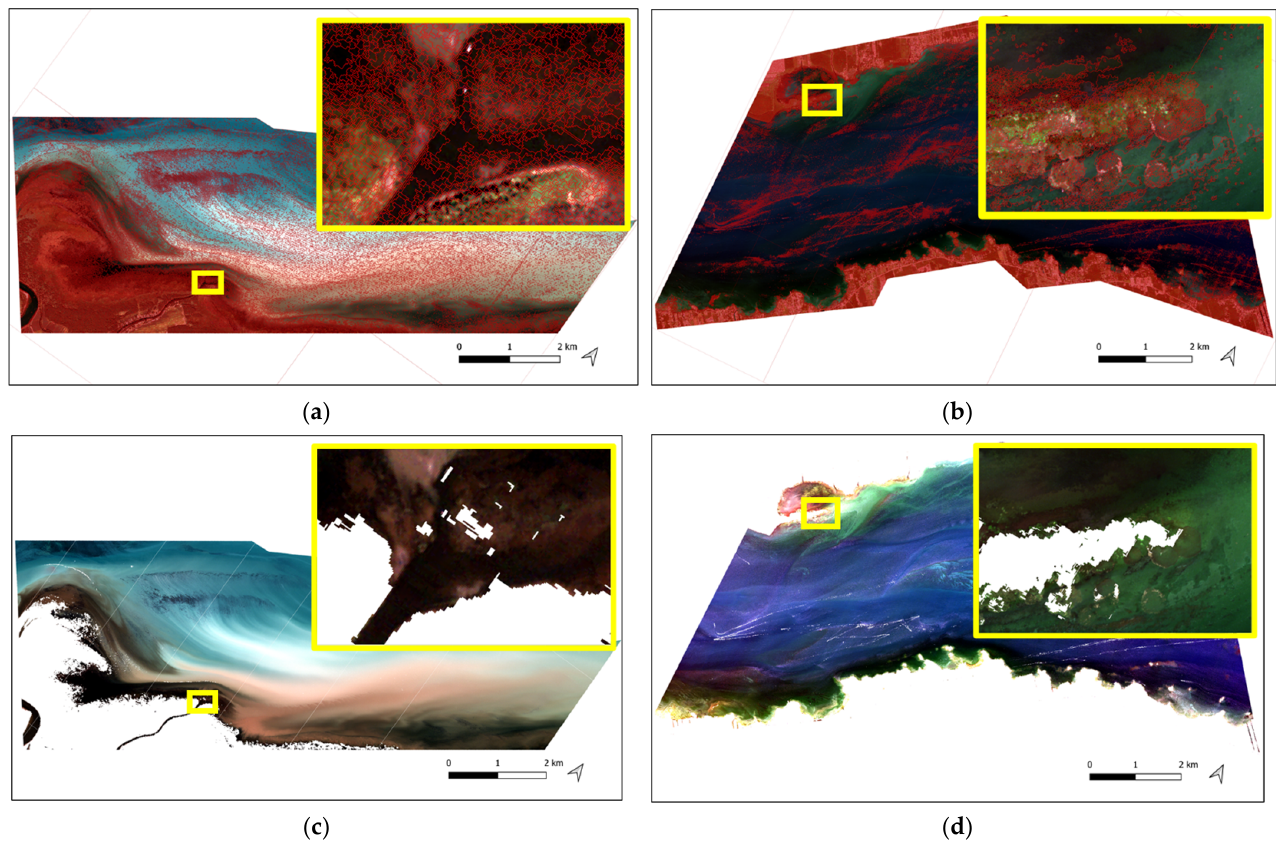
Figure 6. Visualisation of the coarse initial segmentation of the 2009 ( a ) and 2019 ( b ) images and their corresponding land masked products ( c , d ) (© 2022, 2019 Maxar